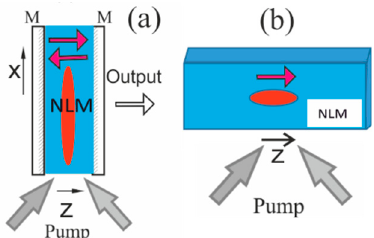
Figure 10. The schemes supporting topological laser solitons. ( a ) A wide-aperture laser with saturable absorber and mirrors M; x is a transverse Cartesian coordinate. ( b ) Cavityless scheme. NLM is nonlinear medium with saturable amplification and absorption, pump is incoherent.